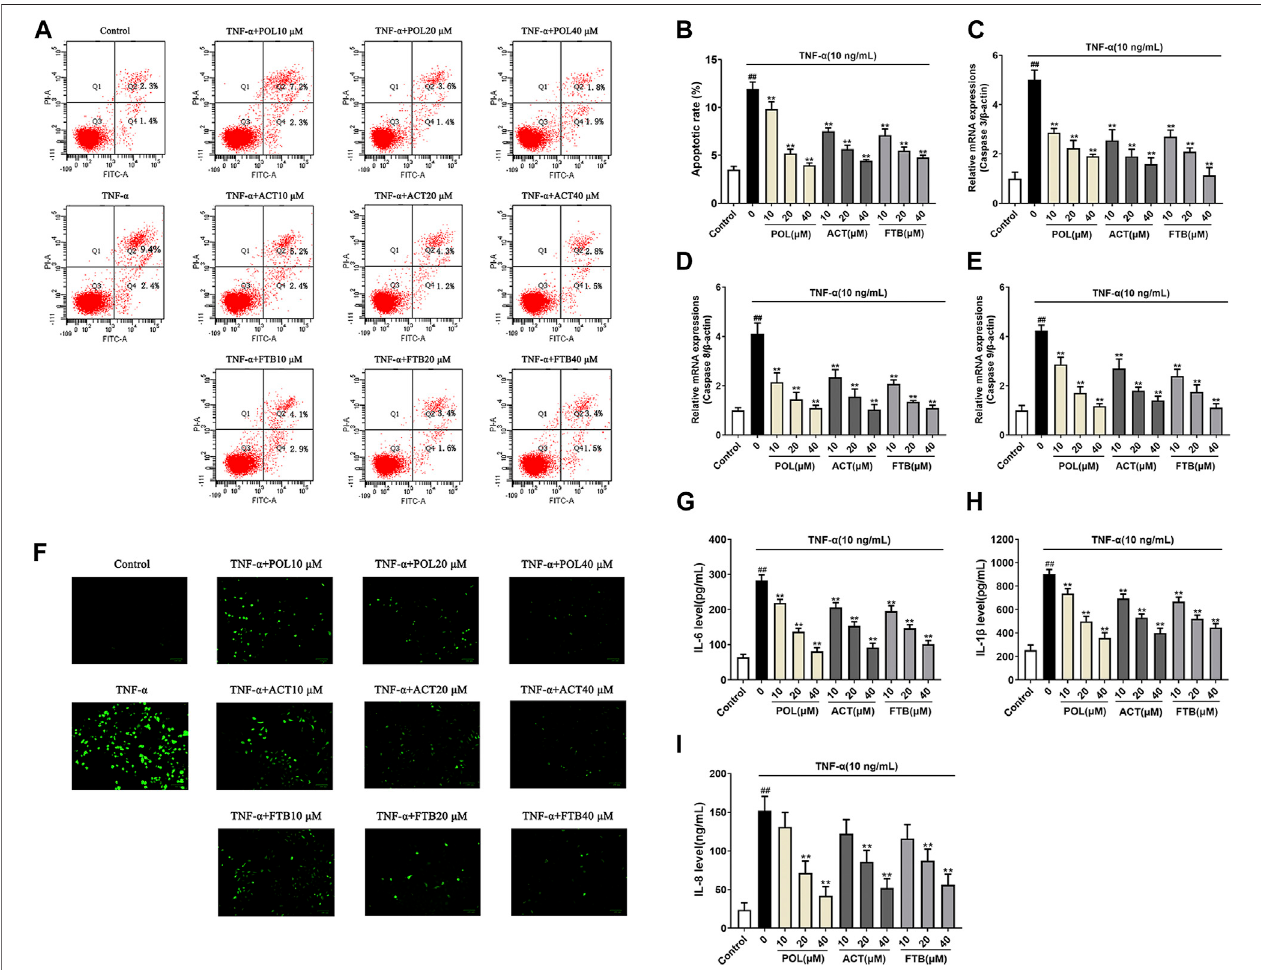
FIGURE3| EffectsofPOL,ACT,andFTBoncellapoptosisrate,ROSlevels,apoptosis-relatedgenesandin fl ammatoryfactors (A,B) EffectsofPOL,ACT,andFTB on TNF- α -induced apoptosis were evaluated using fl ow cytometry (C – E) Relative mRNA expression levels of Caspase 3, Caspase 8, and Caspase 9 (F) Effects ofPOL, ACT, and FTB on TNF- α -induced ROSlevels were observed using a fl uorescence microscope. Scalebar indicates 100 μ m (G – I) Effects ofPOL, ACT,and FTB on TNF- α -induced expression levels ofIL-8, IL-1 β , and IL-6 were determined using ELISA kits. Values representthe means ± SD( n (cid:2) 3-6). ## p < 0.01 vs control, ** p < 0.01 vs TNF- α